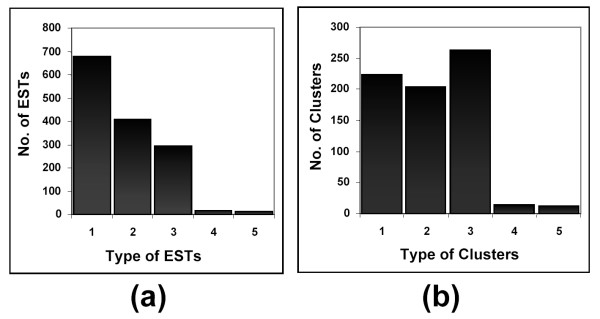
Classification of ESTs (a) and Clusters (b) based on the number of sequences showing similarity to insect and or mammalian proteins in NCBI protein nr database. X-axis: 1) Insect, 2) Insect and Mammal, 3) Unknown, 4) Mammal, 5) Neither Insect nor Mammal, Y-axis: Number of sequences.